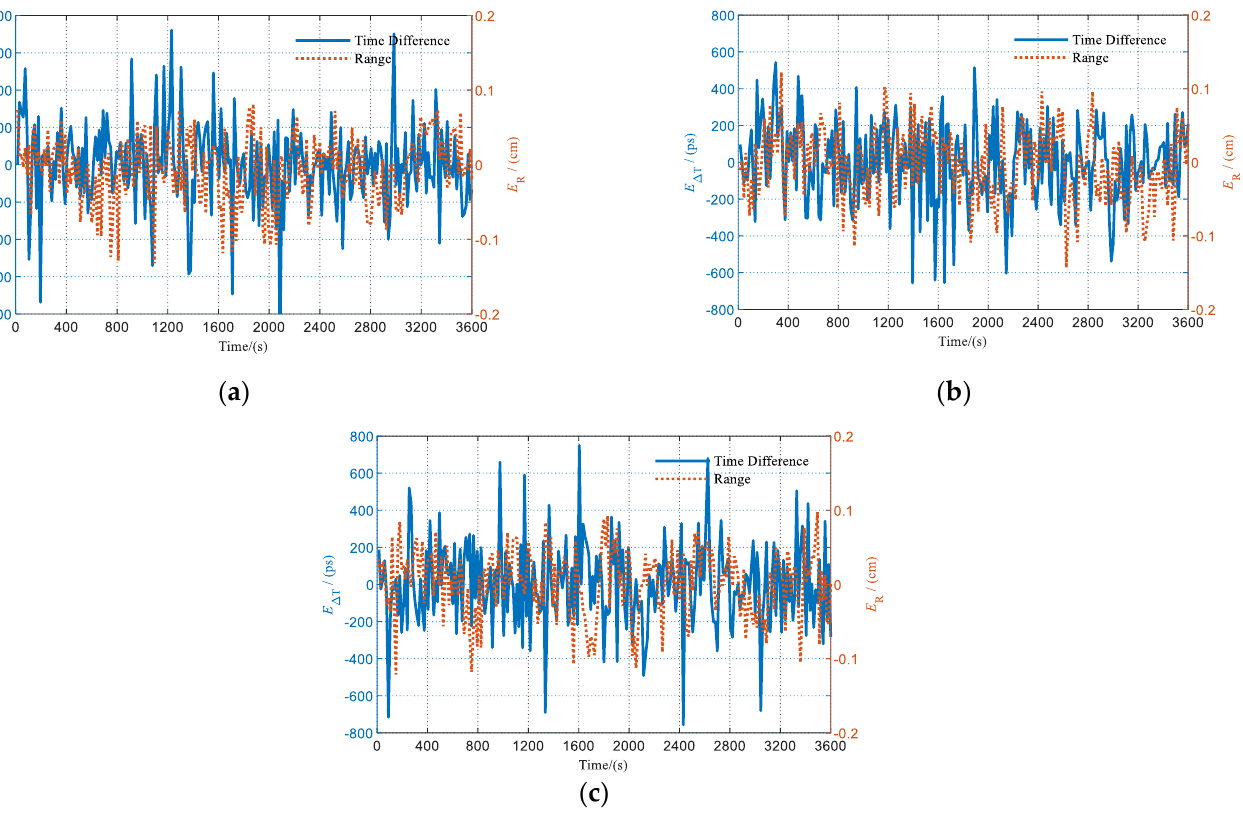
Figure 18. Multi-node joint measurement experimental results: ( a ) measurements between node A and B; ( b ) measurements between node A and C; and ( c ) measurements between node B and C.